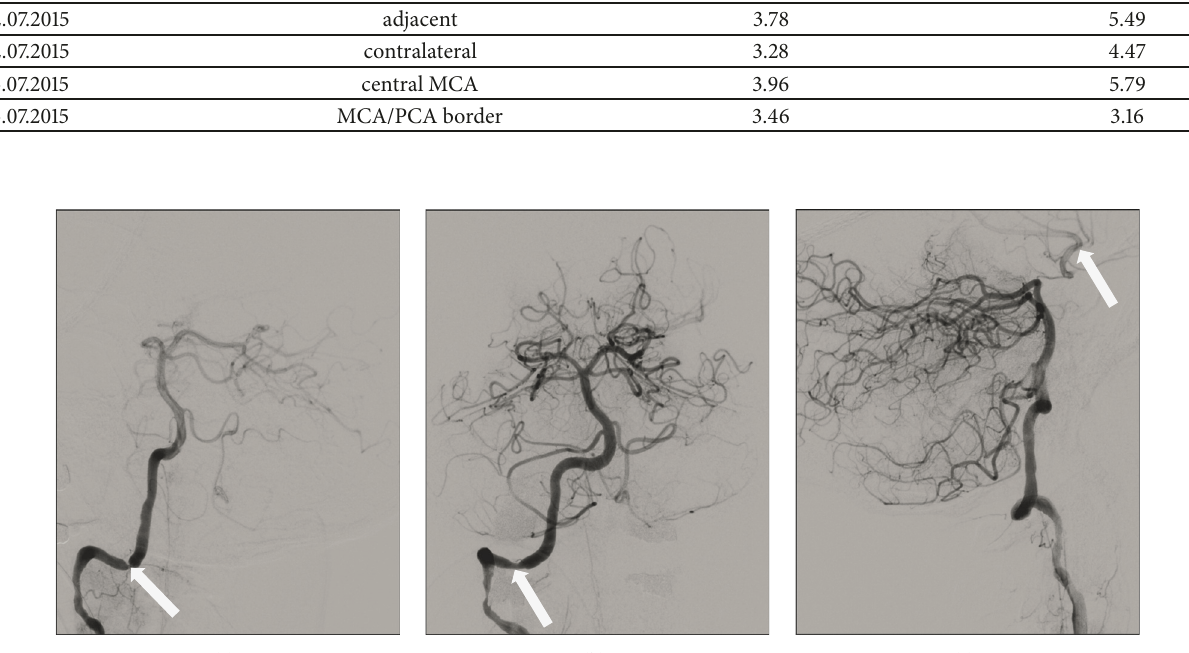
Figure 4: Conventional angiography prior to and after angioplasty. Contrast injections in the right vertebral artery, displaying a high-grade stenosis of the right vertebral artery ((a), arrow), which improved after stent angioplasty ((b), arrow). After angioplasty a new cross-flow via the left posterior communicating artery to the left distal internal carotid artery is seen ((c),